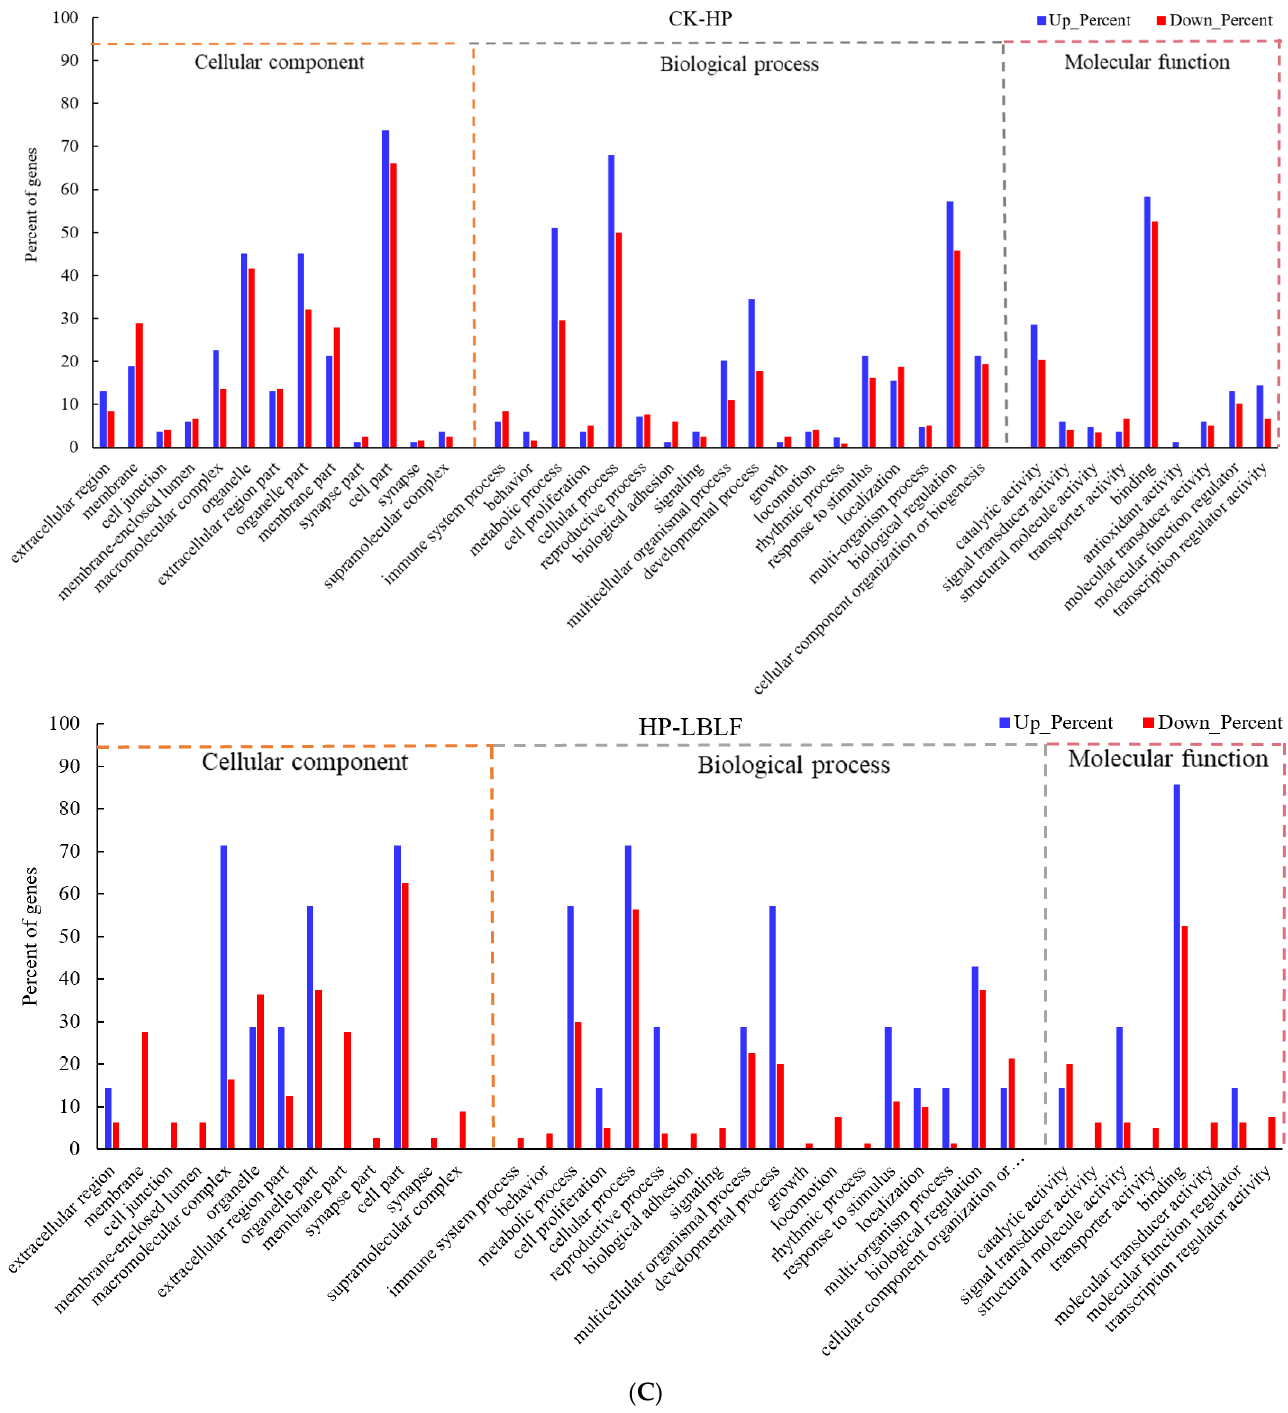
Figure 3. Enrichment of genes differentially expressed between different groups using RNA sequencing ( A ). The upregulated and downregulated genes that are significantly different between H 2 O 2 and H 2 O 2 /LBLF treated HUVECs ( B ). Gene ontology (GO) function classification of the corresponding genes with differentially expressed genes in HUVECs exposed to H 2 O 2 /LBLF ( C ). The top GO enrichment of the differentially expressed genes among control group (CK), 150 µ M H 2 O 2 (HP) and 150 μM H 2 O 2 and 100 µg/mL LBLF cotreated group (LBLF).